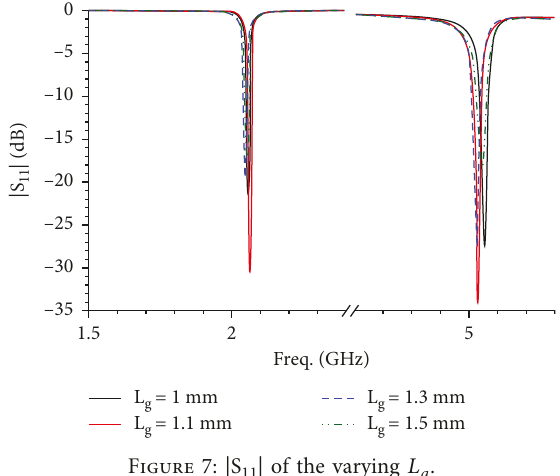
11 | of the varying